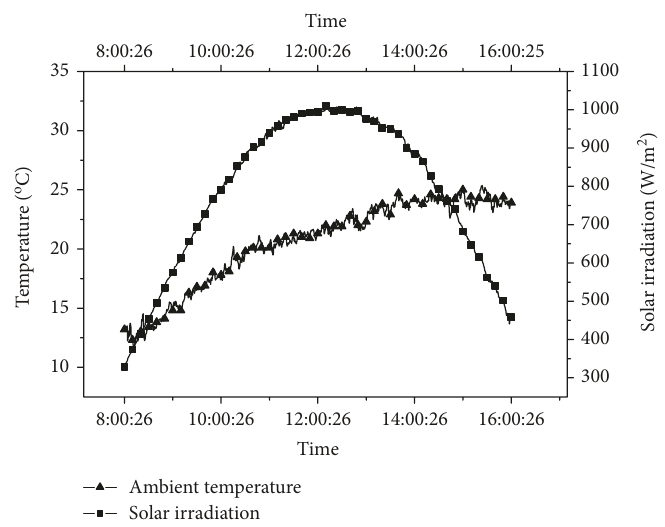
Figure 3: Variations in ambient temperature and solar irradiation on the typical day.